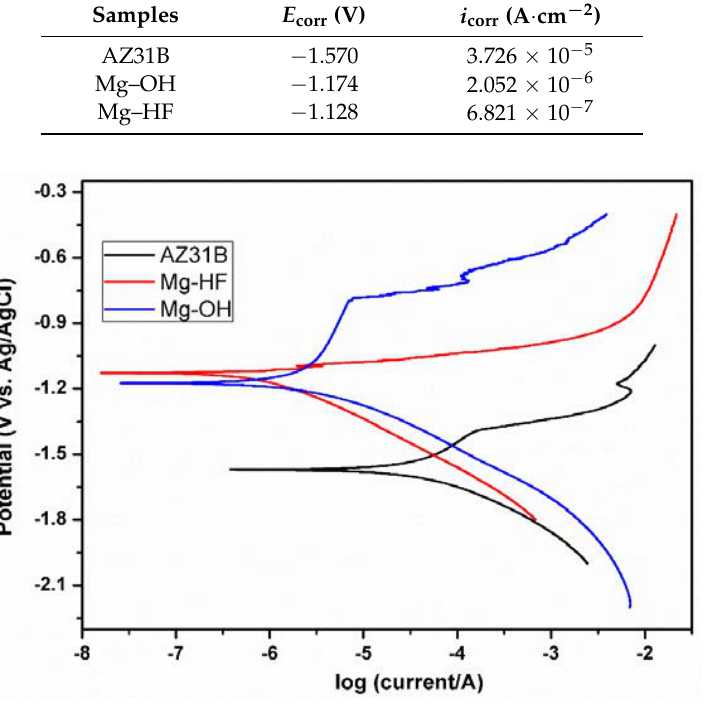
Figure 4. Potentiodynamic polarization curves of different samples in simulated body fluid (SBF) solution at 37 °C.